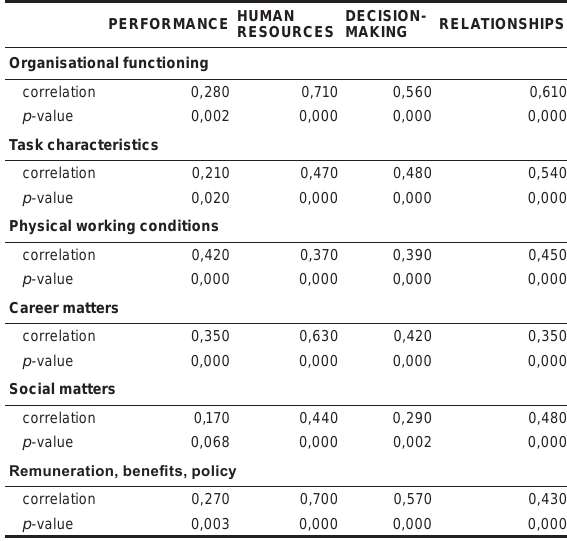
Table 5 Pearson correlations between the domains of the CCQ and the scales of the WLQ